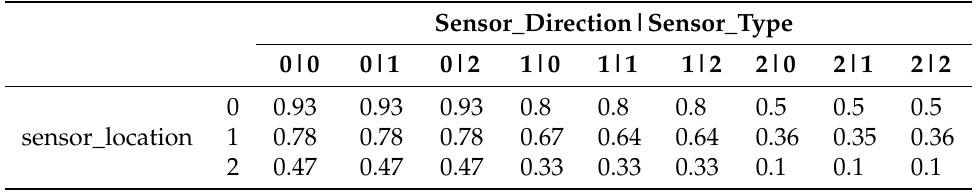
Table A2. Look-up table for Sensor system